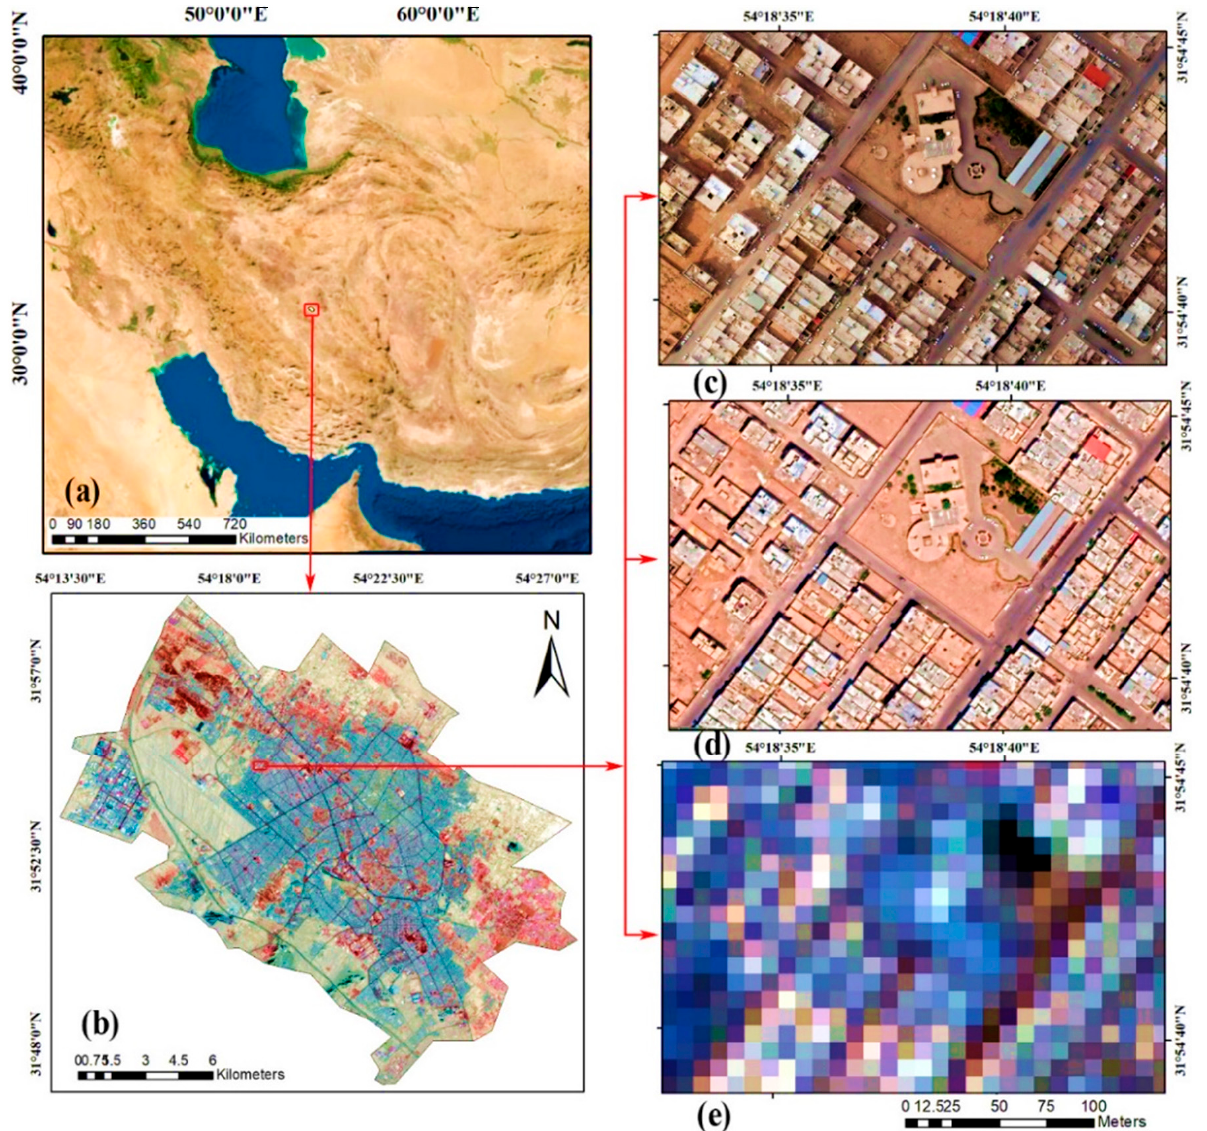
Figure 1. ( a ) Location of Yazd in central Iran, ( b ) the study area in Yazd city, and examples of ( c ) unmanned aerial vehicle (UAV), ( d ) Google Earth and ( e ) Sentinel-2 images of the study area.